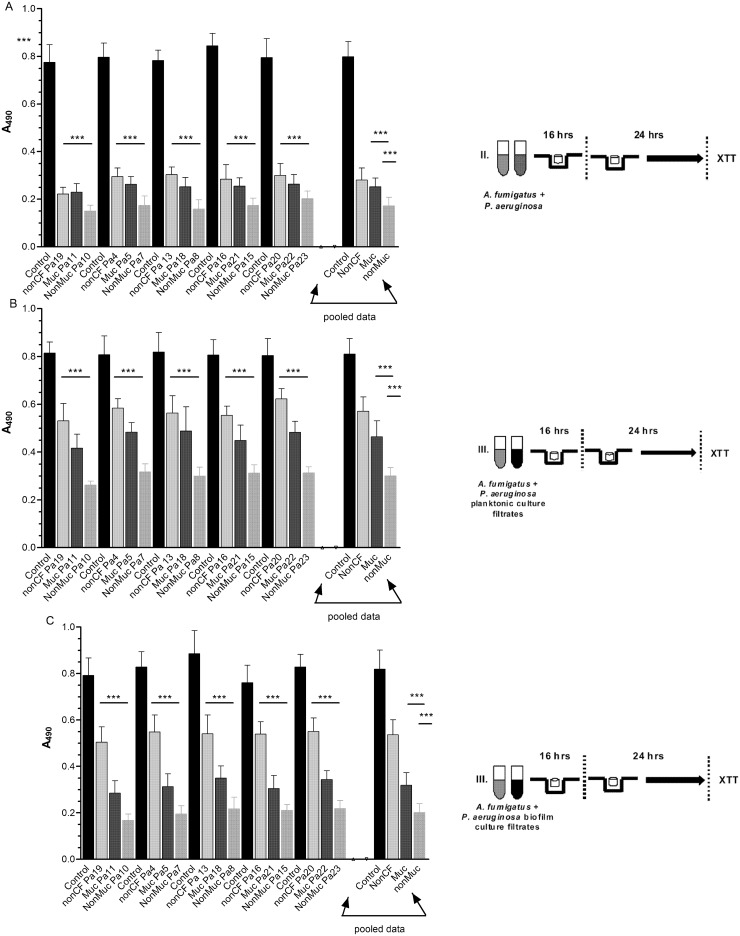

Pa inhibition of Af during biofilm formation.The data presented show the activity of each live Pa isolate or planktonic- or biofilm-generated Pa culture filtrate on Af during formation of biofilm by Af. Individual isolate results are shown in comparison with their respective Af controls (n = 6 for each). There were five non-CF, five mucoid CF and five non-mucoid CF isolates tested; isolate designations are shown on the x-axis. The bars on the far right of each panel represent the pooled data for each type of isolate (n = 30). Bars represent the mean ± SD of the XTT reduction read at 490 nm. (A) Af conidia were exposed to live Pa cells for 16 h. (B) Af conidia were exposed to Pa planktonic supernatant for 16 h. (C) Af conidia were exposed to Pa biofilm supernatant for 16 h. The resulting readings were determined. “XTT metabolic activity” refers to the spectrophotometric absorbance of the formazan reduction product of XTT at 490 nm. Assays were performed in blocks with two runs of triplicates done on different days, for each Pa-Af combination. Panel (A) All individual Pa isolates, noted on the x-axis, were significantly inhibitory compared to controls (P<0.001). The four bars on the right side show the pooled data. CF mucoid and CF non-mucoid cells were more inhibitory than non-CF Pa cells (P<0.001, both comparisons), with CF non-mucoid cells more inhibitory than CF mucoid cells (P<0.001). Panel (B) Planktonic culture filtrate from all individual Pa isolates, were significantly inhibitory compared to controls (P<0.001). Pooled data analysis showed both CF mucoid or CF non-mucoid isolate culture filtrate was more inhibitory than that from non-CF isolates (P<0.001, both comparisons) and non-mucoid was more inhibitory than mucoid (P < 0.001). Panel (C) Culture filtrates from all Pa isolates grown as biofilm were significantly inhibitory (P<0.001). Pooled data showed culture filtrate from CF non-mucoid isolates under biofilm conditions was more inhibitory than that from CF mucoid or non-CF isolates under the same conditions (P<0.001, both comparisons), and that non-mucoid CF filtrates were more inhibitory than mucoid isolate filtrates (P < 0.001).